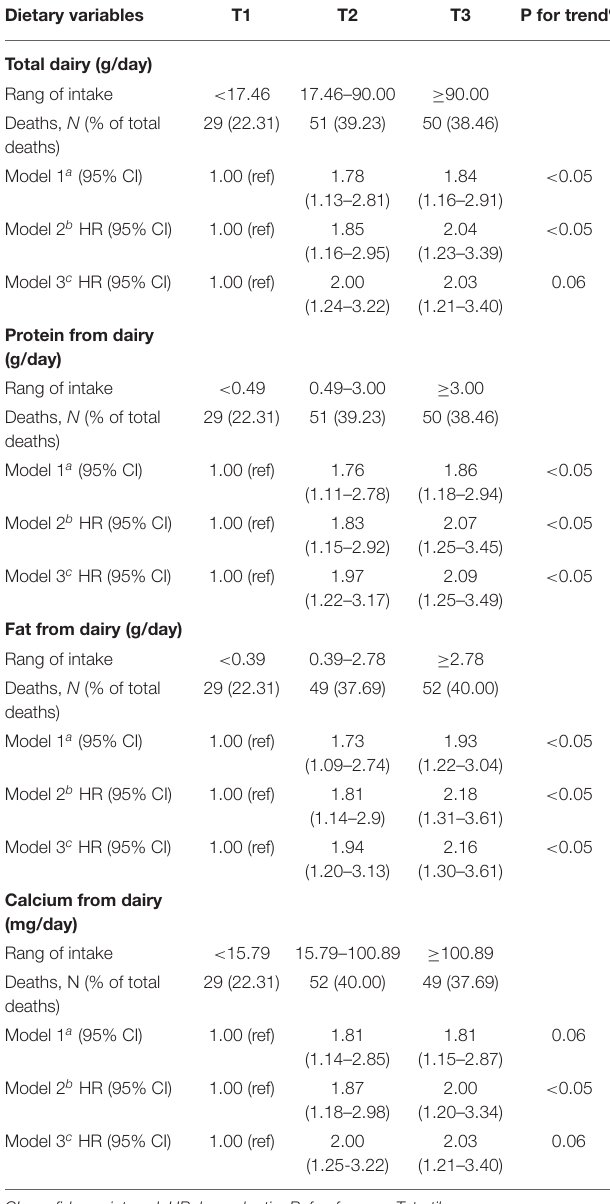
TABLE 3 | Hazard ratio (95% CI) for overall survival among ovarian cancer patients according to total dairy and relative nutrients intake. Dietary variables